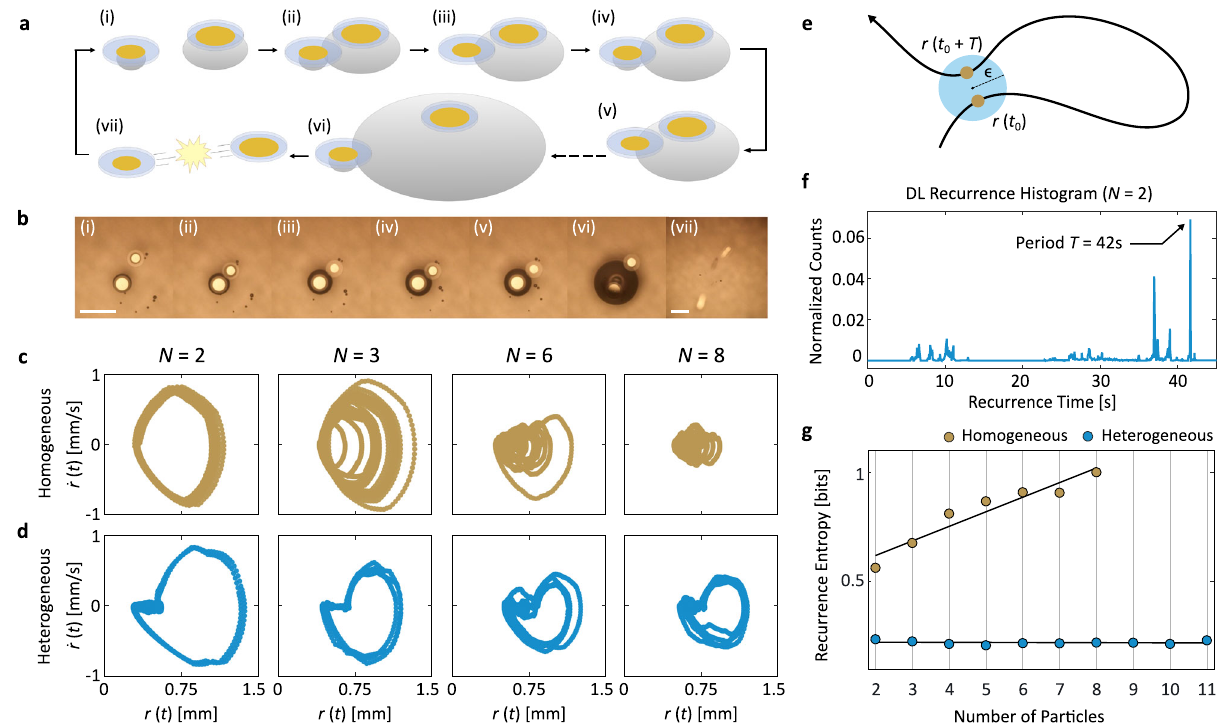
Fig. 3 | Designated leaders induce periodic limit cycles. a , b Features of DL beating explained with schematic ( a ) and micrograph sequence ( b ) of a 2-particle heterogeneoussystem.Theleaderparticleisabletogrowalargebubblepromptly and subsume the smaller bubbles of neighbouring particles across several rounds of bubble coalescence. Scale bars, 1 mm. c , d , Phase portraits of homogeneous ( c ) and heterogeneous ( d ) systems of N =2,3,6,and 8. Only the latter is able to maintain the closed-loop orbits at high particle counts. e Schematic of recurrence time calculation. The recurrence time is the time it takes to return from a given